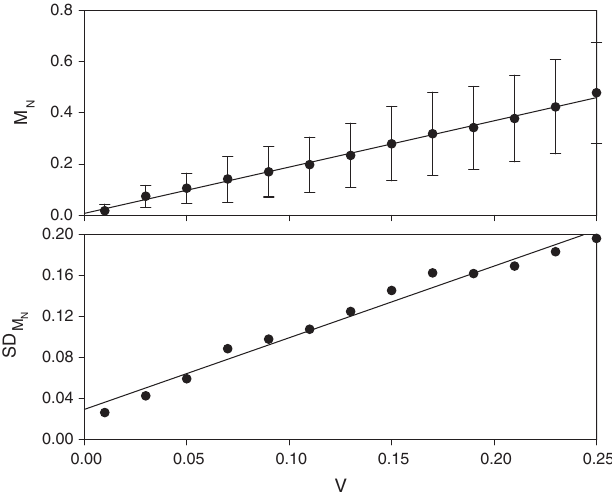
FIG. 10. Normalized misassignment rate M and the standard deviation in normalized misassignment rate SD versus M N